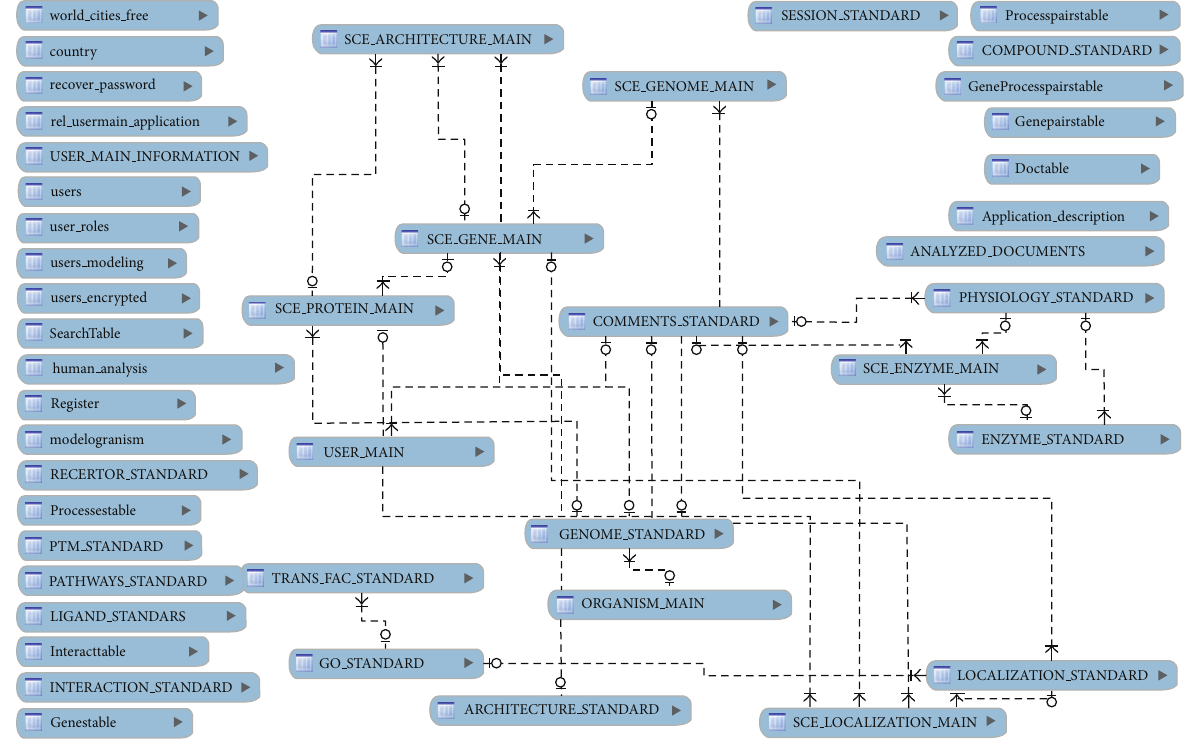
Figure 4: Simplified database schema.